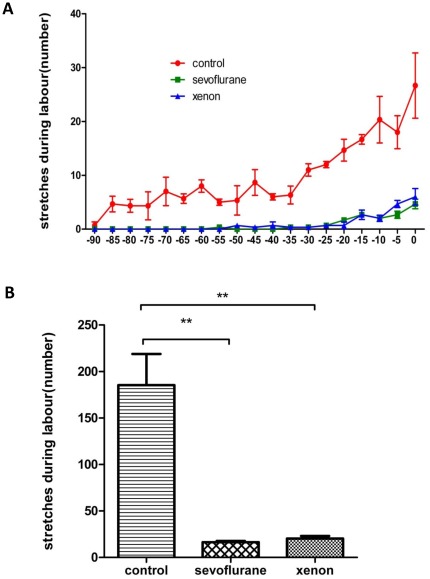
Pain stretching behavior during labor.The time course (A) and counting (B) of stretches, either inward turning of the hind paw or straining of the abdomen, which represent uterus contraction-related pain 90 min prior to birth delivery. Dams from sevoflurane or xenon groups had a significant decrease of stretches compared to control group. Data are expressed as mean ± SEM (n = 4); **p<0.01. Bar = 100 µm.